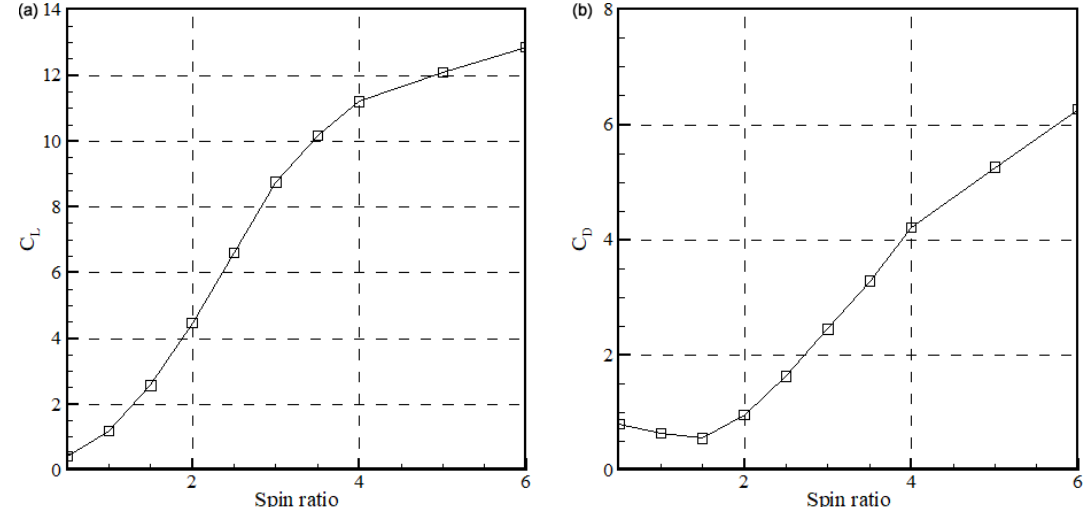
Figure 10. Experimental results of Charrier (Charrier, 1979) for the aerodynamic coefficients of a Flettner rotor. Panel (a) shows the lift coefficient. Panel (b) shows the drag coefficient. In the experiments, the rotor was fitted with end disks at both ends. The diameter of the disks was twice the diameter of the rotor. The aspect ratio of the rotor was 5 and the Reynolds number was